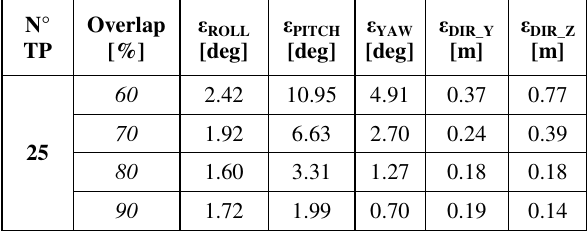
Table 1. Error propagated - 25 TP – simulation